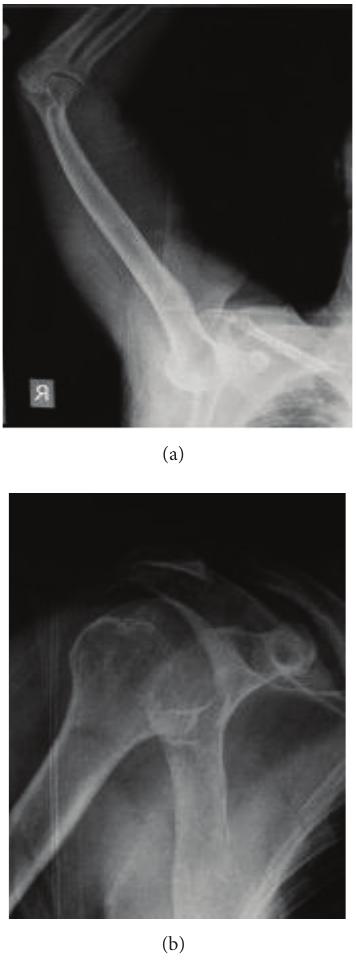
Figure 2: X-ray of the humeral head located below the rim of glenoid and X-ray after the reduction was